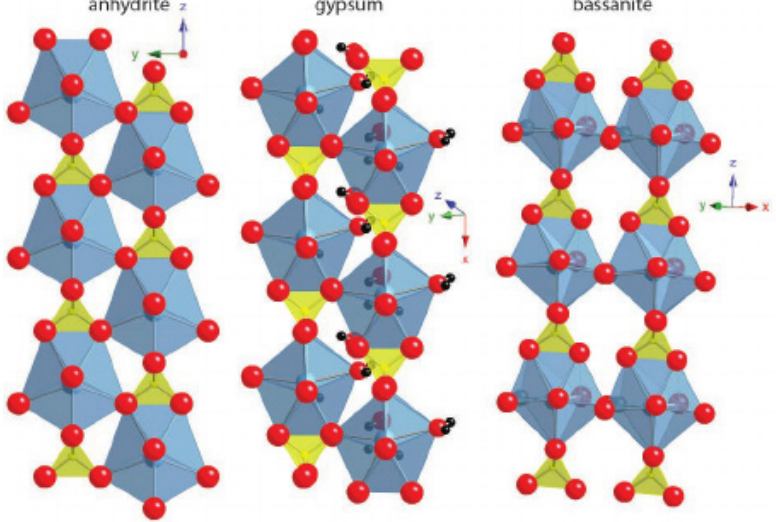
Figure 6. Anhydrite, gypsum and bassanite crystalline structures. Pictures from Janice L. Bishop et al. (2014) [42].